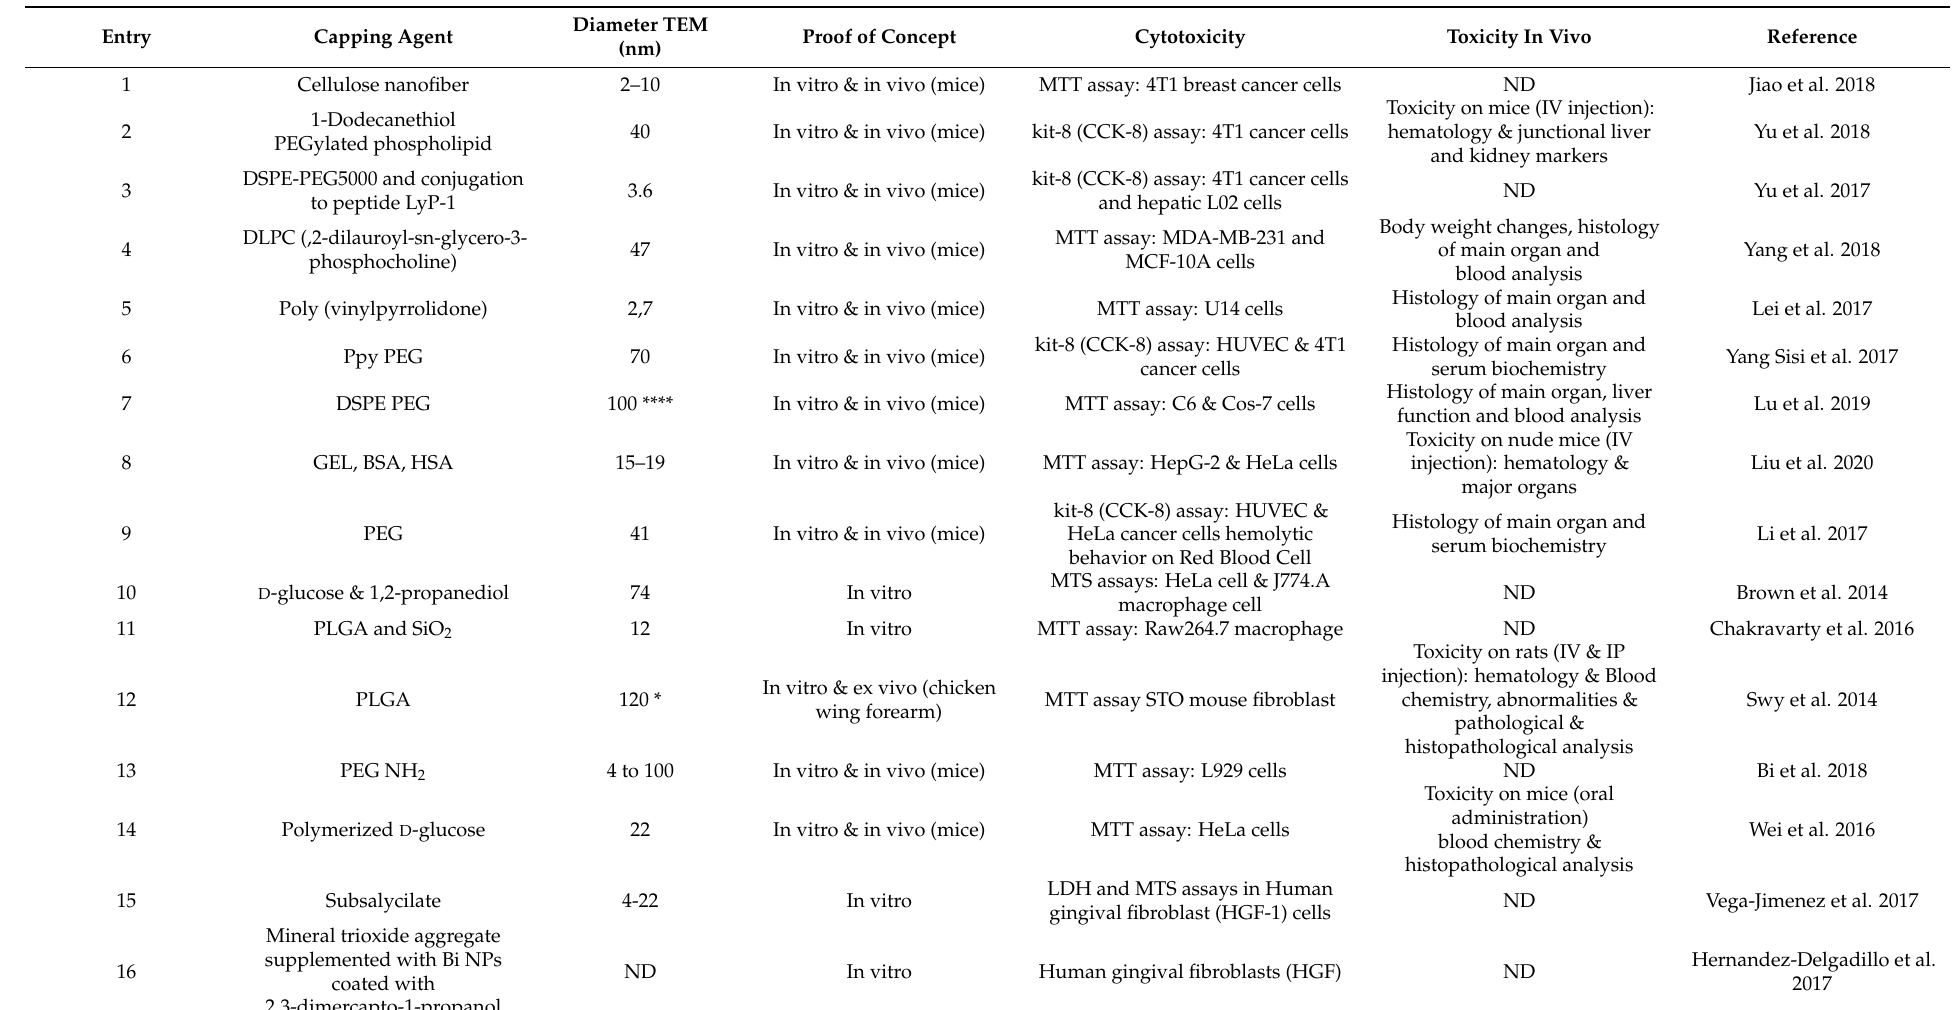
Table 3. Biocompatibility and toxicity of metallic bismuth